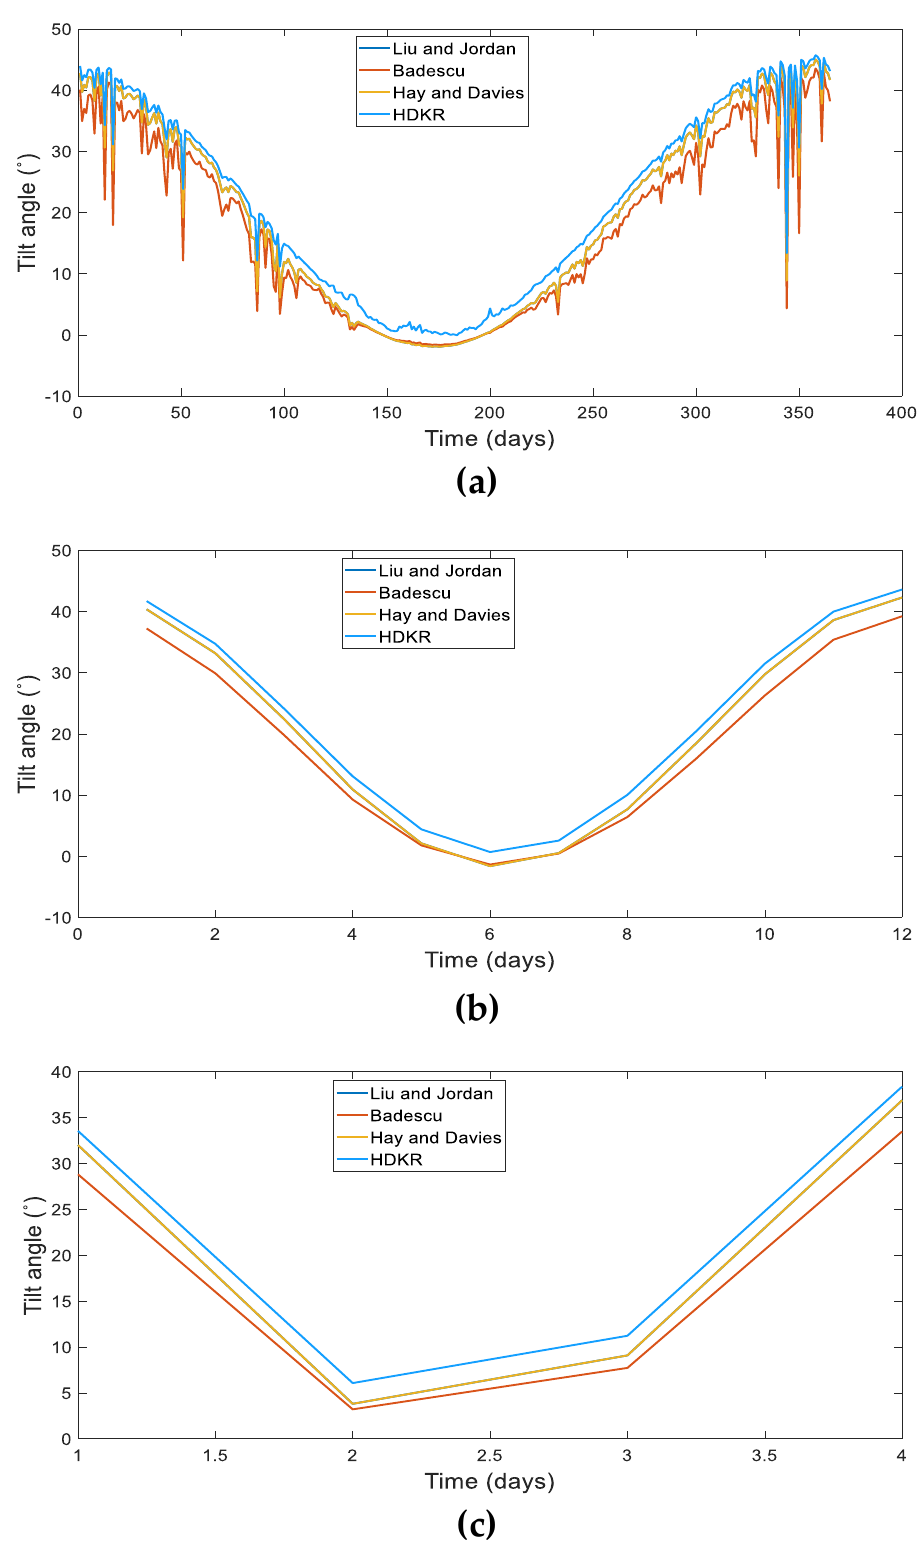
Figure 8. Comparison of the optimized tilt angles among different models in Makkah city during various periods: ( a ) NP = 365, ( b ) NP = 12, ( c ) NP =